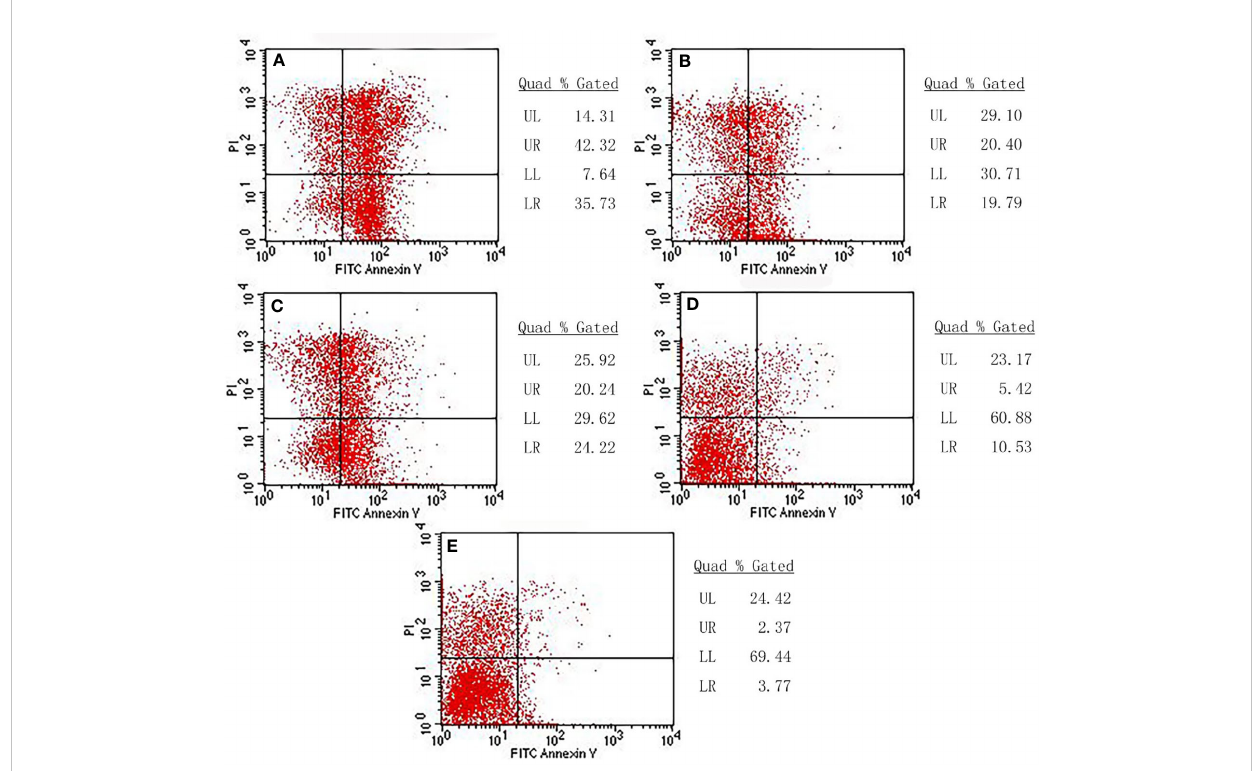
investigated the combined treatment of immunogene therapy and magnetic fl uid hyperthermia using Fe 3 O 4 nanoparticles as the medium on cancer, which demonstrated strong synergies.